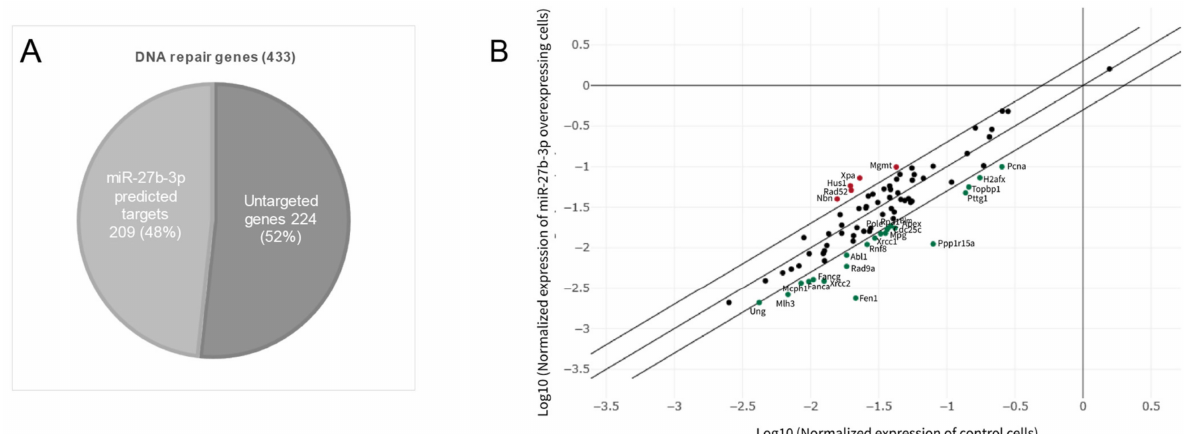
Figure 2. miR-27b-3p overexpression induces changes in DNA repair gene expression. ( A ) Proportion of DNA repair genes predicted to be regulated by miR-27b-3. ( B ) Gene expression pattern induced by miR-27b-3p overexpression. The scatter plot compares the normalized expression of every gene on the PCR array between the control and miR-27b-3p overexpressing cells by plotting them against one another to quickly visualize large gene expression changes. The center diagonal line indicates unchanged gene expression, while the outer diagonal lines indicate the selected fold regulation threshold. Fold-change (2ˆ(-Delta Delta CT)) is the normalized gene expression (2ˆ(- Delta CT)) in the test sample divided by the normalized gene expression (2ˆ(- Delta CT)) in the control sample. Fold-change values greater than one indicate a positive or upregulation. Fold-change values less than one indicate a negative or downregulation. The p -values were calculated based on a Student’s t -test of the replicate 2ˆ(- Delta CT) values for each gene in the control and miR-27b-3p overexpressing groups, and p -values less than 0.05 were considered for analysis. The p -value calculation used is based on parametric, unpaired, two-sample equal variance, two-tailed distribution—a method widely accepted in scientific literature. Upregulated genes: Nbn, Rad52, Hus1, Xpa, and Mgmt. Downregulated genes: Ung, Mlh3, Mcpn1, Fanca, Fancg, Xrcc2, Fen1,